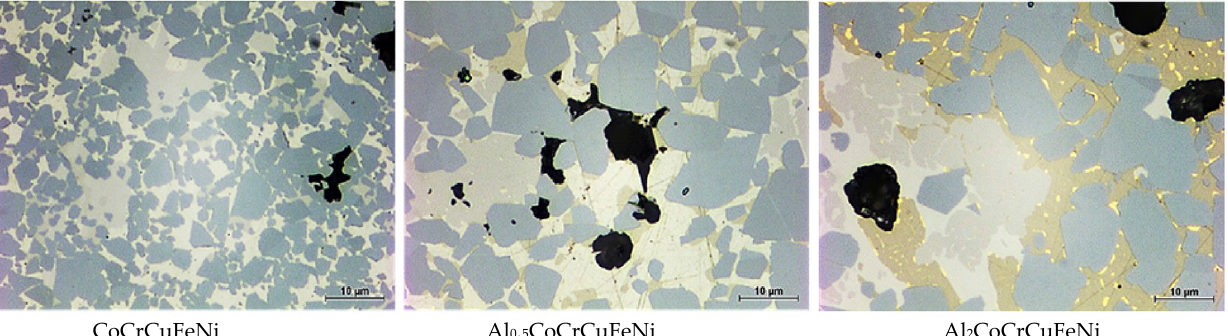
Figure 4. Microstructures of cemented carbides with the CoCrCuFeNi, Al 0 . 5 CoCrCuFeNi and Al 2 CoCrCuFeNi HEA binders sintered at 1500 °C in a vacuum for 2 h. Reprinted with permission from Ref. [61]. Copyright 2019 Elsevier.